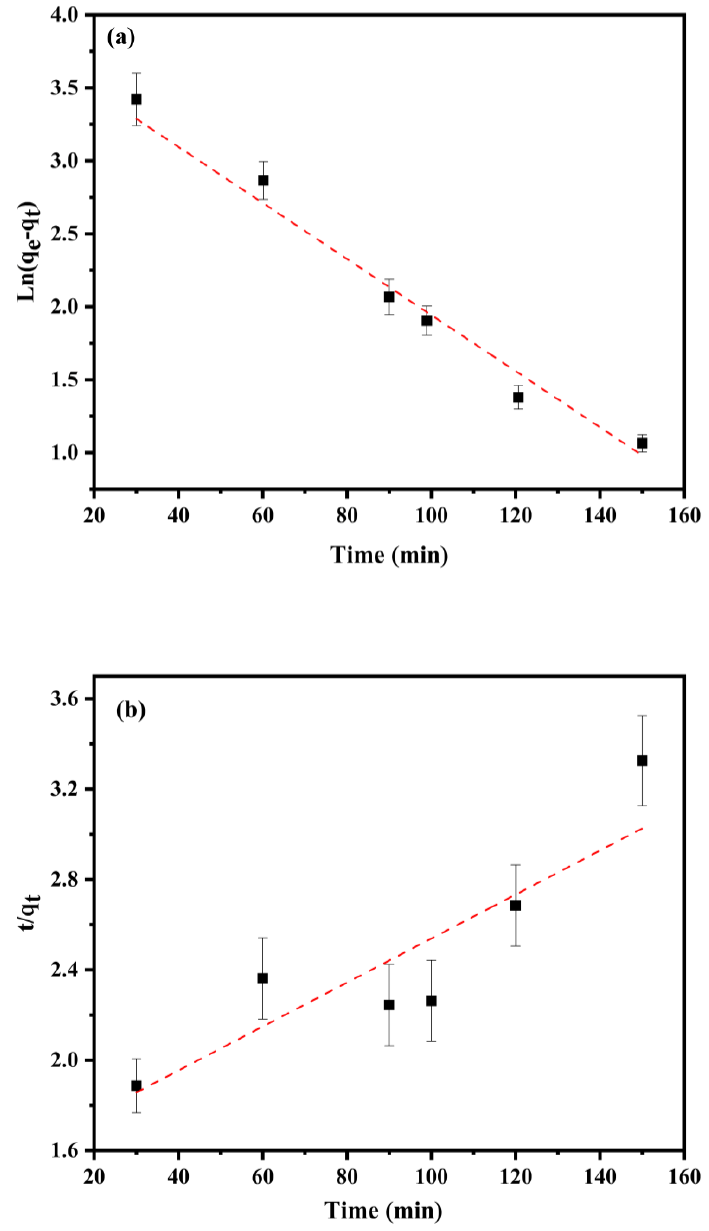
Figure 10. ( a ) Pseudo-first order and ( b ) Pseudo-second-order adsorption kinetics of COD onto the